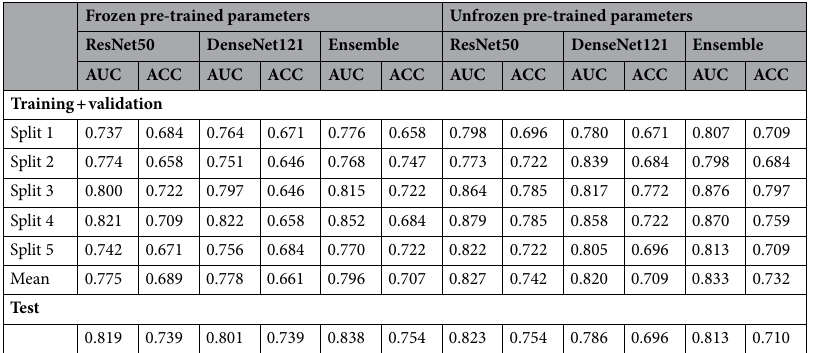
Table 2. Classification performance of the cross-validation and testing of the CNN architectures trained with frozen and unfrozen pre-trained parameters. Classification accuracy and AUC values for each validation split of the cross-validation and mean over all splits. The classification accuracy and AUC values of ensembles of the cross-validated models on the test set. AUC area under the curve, ACC accuracy.